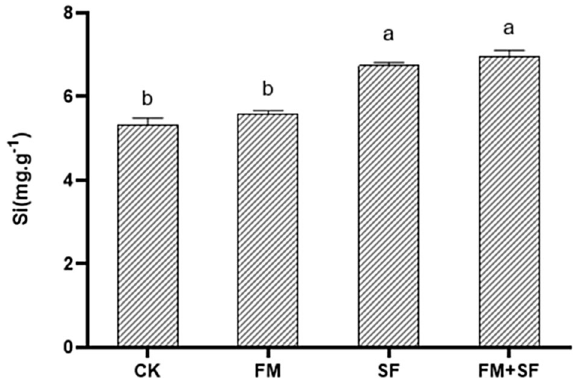
Figure 2. Effect of bast fiber film and nano-silicon fertilizer treatments on silicon content in rice stalks. Different letters indicate significant difference at 5% level. Control (CK), no bast fiber film, no nano-silicon fertilizer; FM, seedlings cultivated with bast film; SF, seedlings cultivated with nano-silicon fertilizer; FM + SF, seedlings cultivated with bast fiber film and nano-silicon fertilizer.